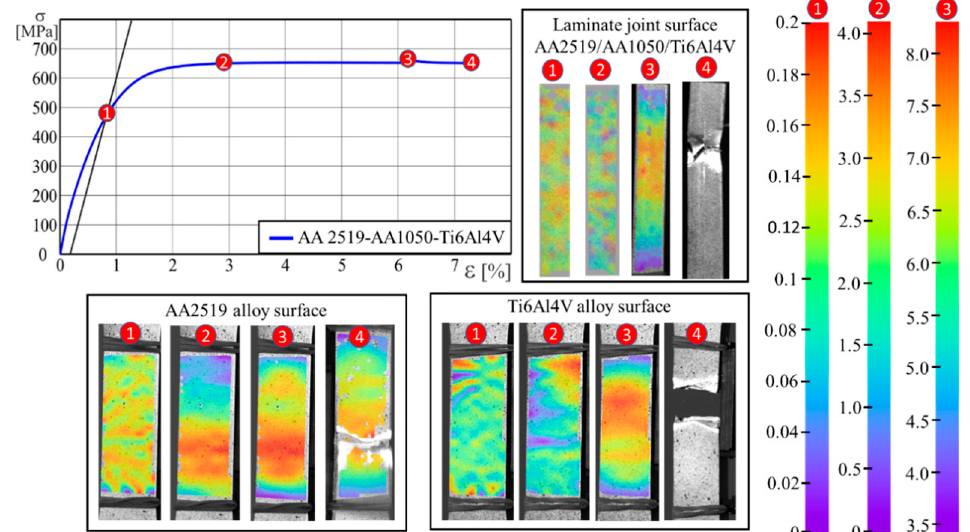
Figure 7. Deformation distribution using the digital image correlation (DIC) method for selected points of the monotonic tensile test of a flat-layered AA2519-AA1050-Ti6Al4V composite sample: 1: conventional yield point R 0.2 , 2: tensile strength for ε p = 2%, 3: maximum tensile strength R m and 4: crack sample.